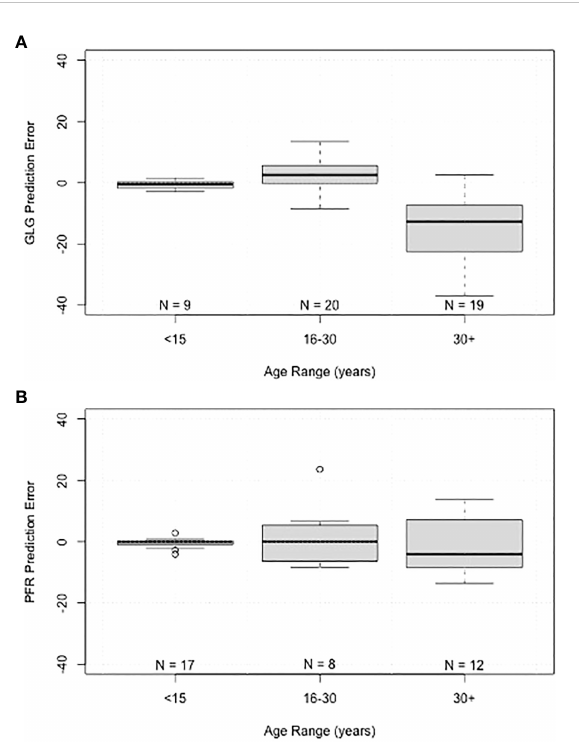
FIGURE 6 Boxplots of prediction error grouped by age range for (A) tooth growth layer group (GLG) age estimates, and (B) pectoral fl ipper radiography (PFR) age estimates. Boxes represent interquartile range, line within boxes represents median, whiskers represent non-outlier range, and points represent